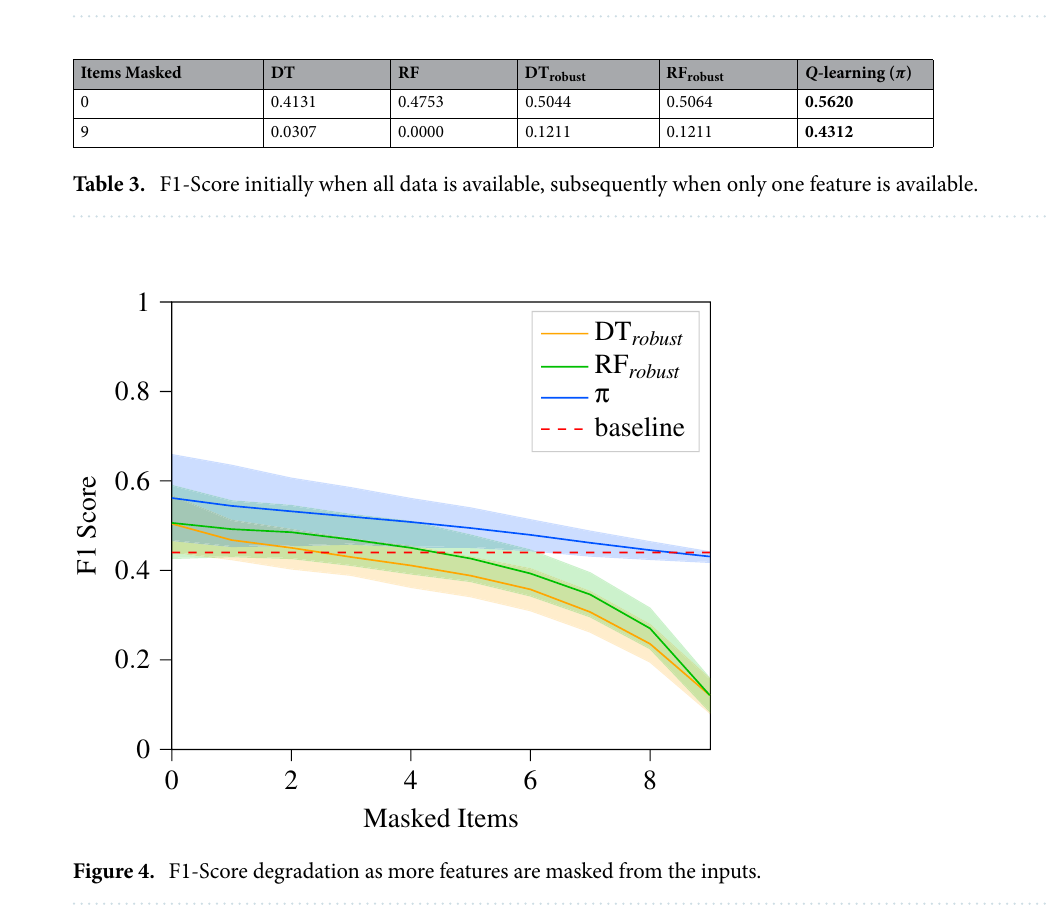
Figure 3. Process demonstrates how a single example is converted into masked examples. The 0s represent values that are unavailable to the classifier a priori and will be potentially imputed. The notation C choose n ) represents the number of examples generated by masking n